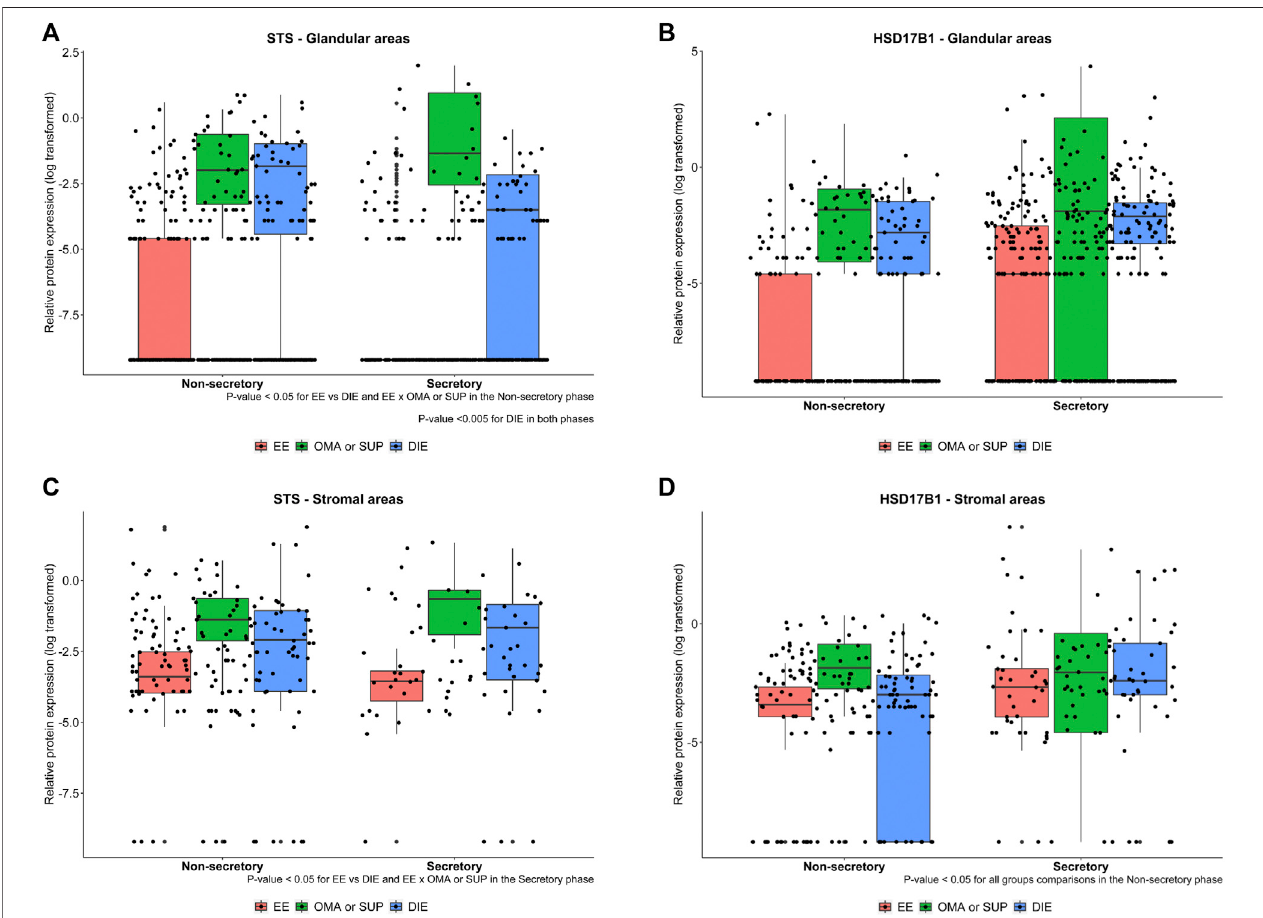
FIGURE 6 | Representative images from STS and HSD17B1 protein expression in glandular (A, B) and stromal areas (C, D) from endometriotic samples. Protein expression levels of STS and HSD17B1 were analyzed by immunohistochemistry in eutopic endometrium from endometriosis patients (EE), ovarian (OMA), super fi cial (SUP),anddeep-in fi ltrating(DIE)lesions.Samplesweredividedintononsecretoryandsecretoryphaseofthemenstrualcycle.Barsrepresentthelog 10 meanfoldchange of the relative protein expression, accompanied by 95% CI. Statistical differences between groups are indicated by * p < 0.005.